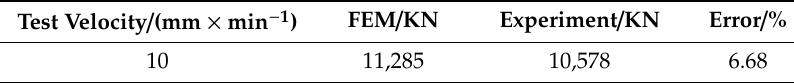
Table 2. The peak load error of the experiment and FEM.